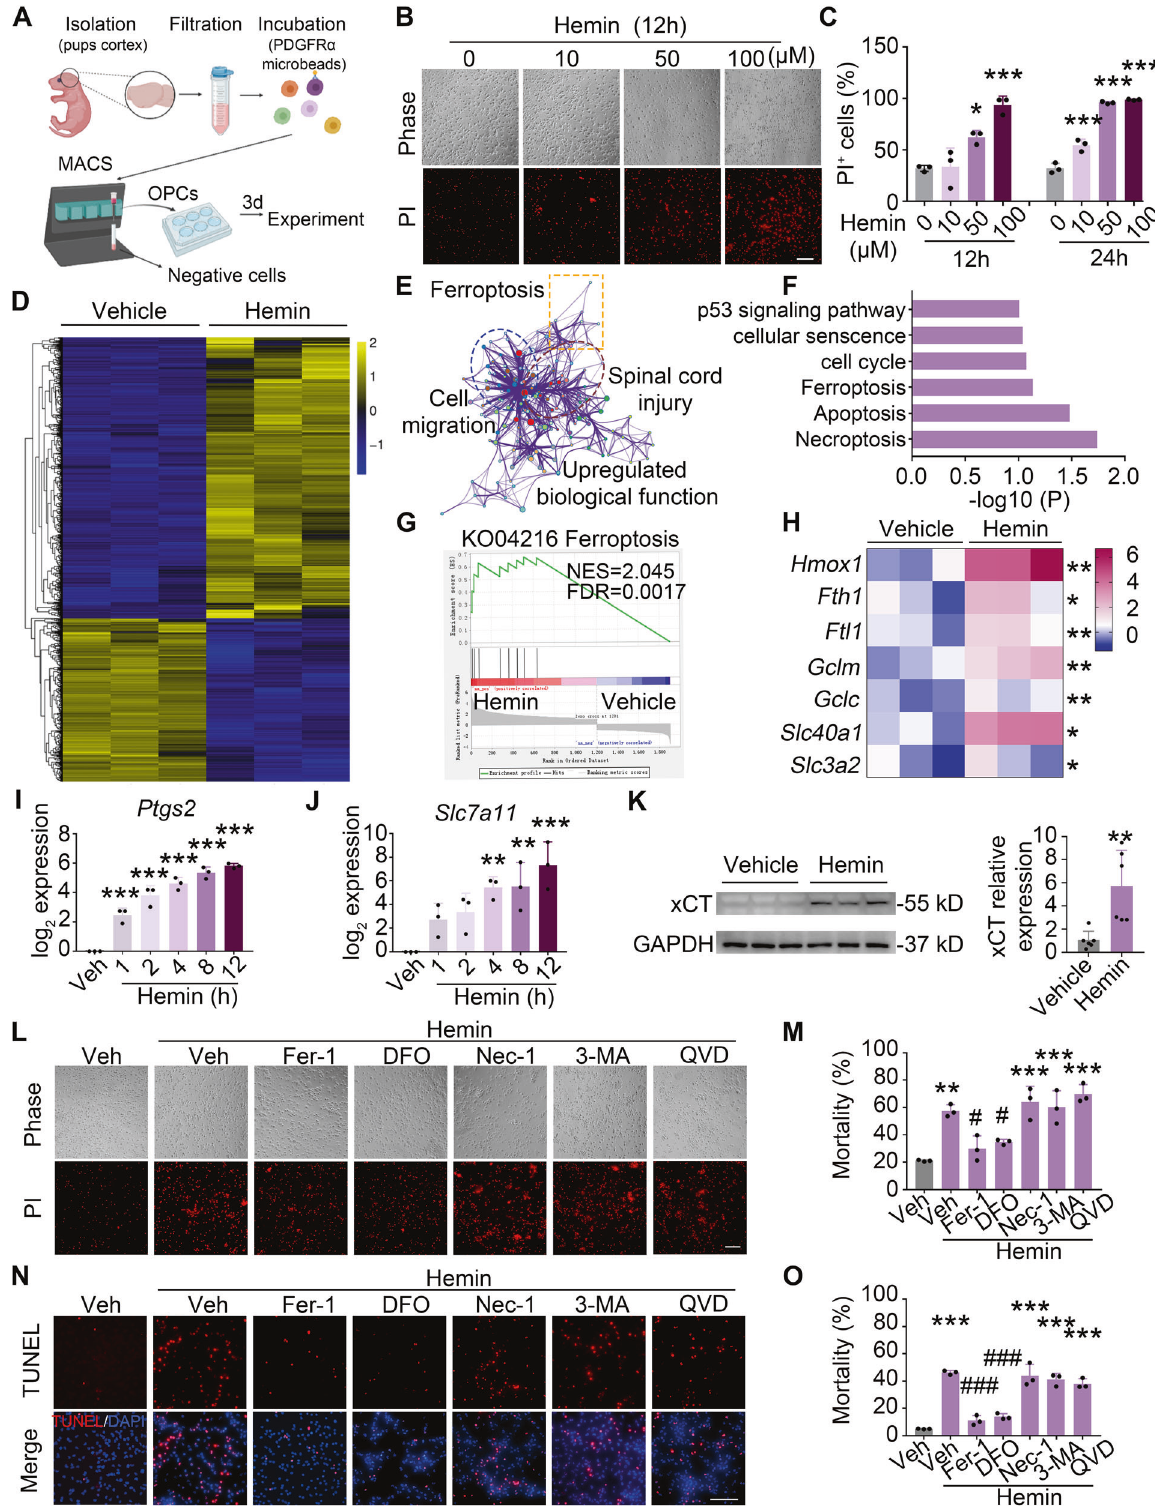
DISCUSSION Oligodendrocytes are the myelinating cells in the central nervous system (CNS). They participate in myelin formation, accurate wrapping, and repair in development and various diseases [8]. Mature oligodendrocytes are derived from